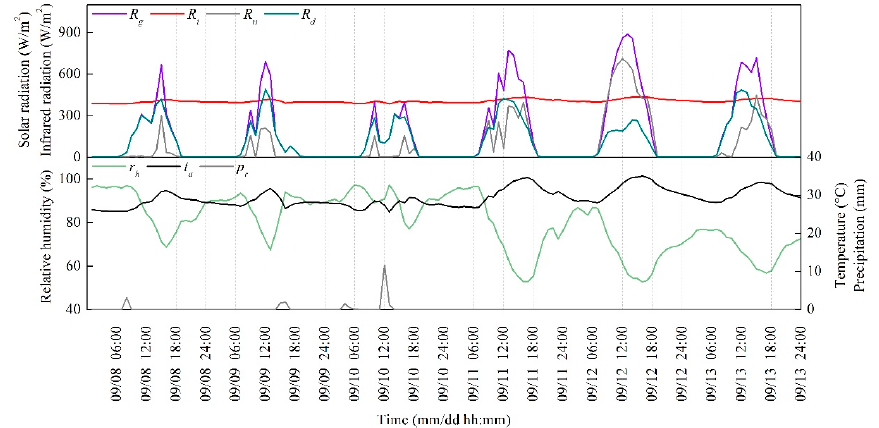
Figure 5. Meteorological data in the air-conditioning experimental conditions. R g : global horizontal solar radiation; R i : horizontal infrared radiation intensity from the sky; R n : direct normal solar radiation; R d : diffuse horizontal solar radiation; r h : relative humidity; t a : air temperature; and p r : precipitation.